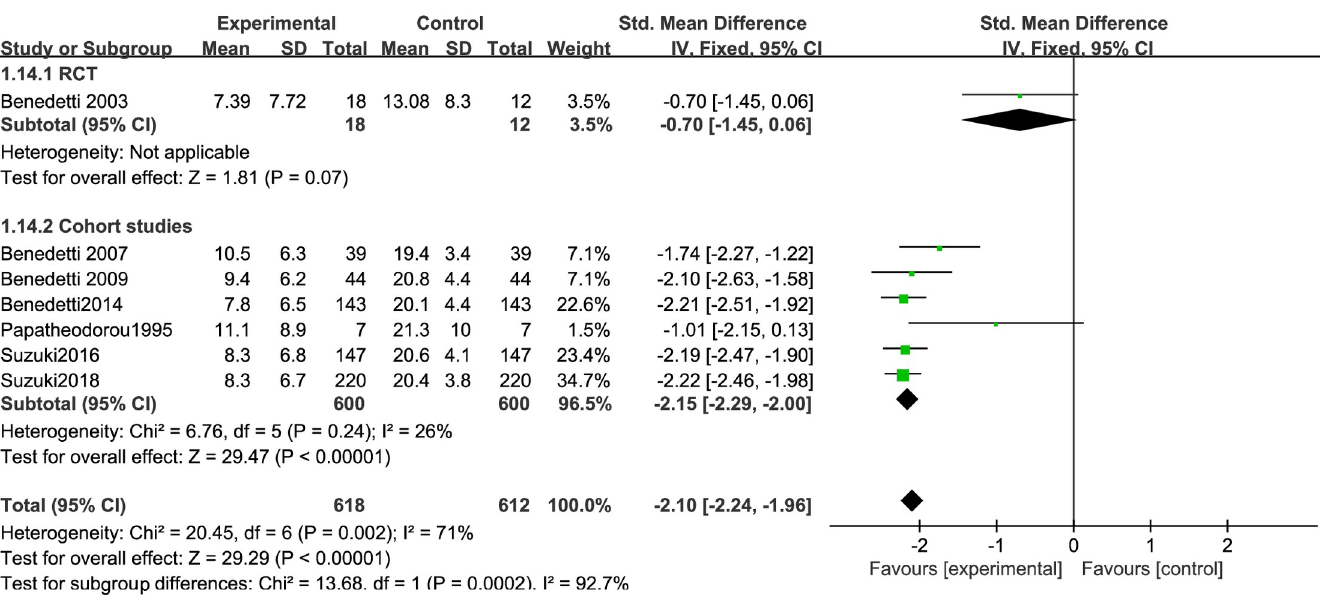
three studies with color temperatures greater than 4500k, and two studies with less than 4500k.